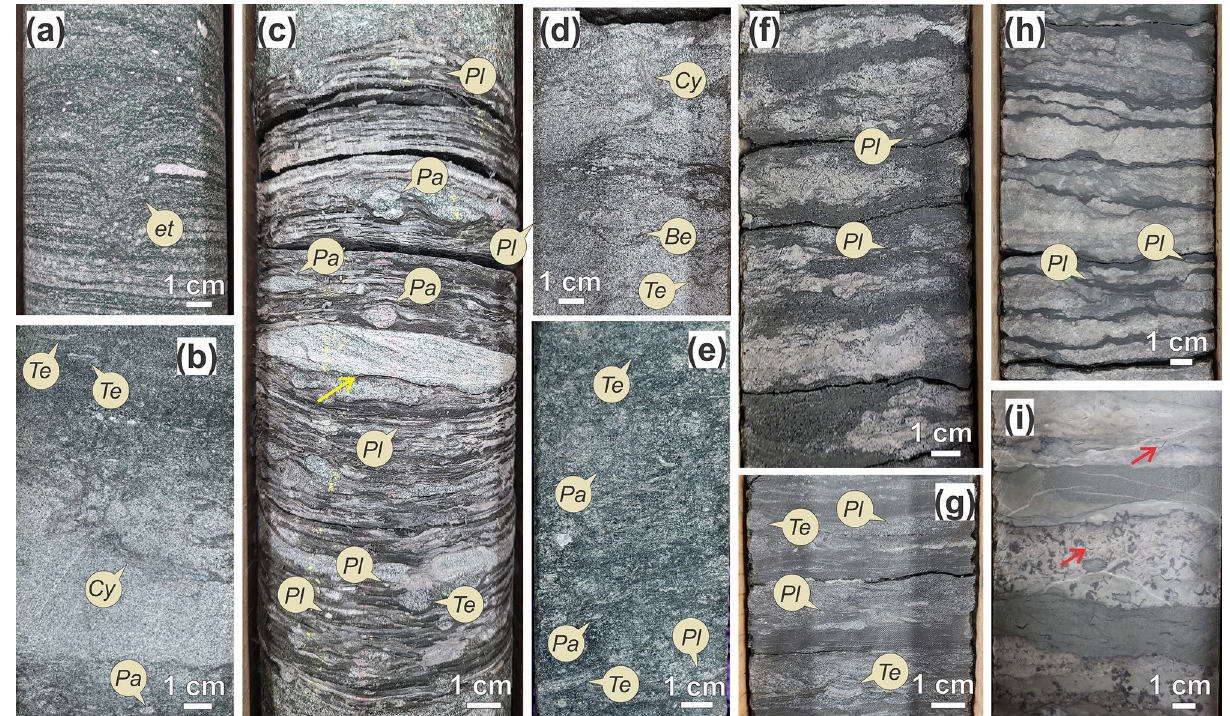
Figure 3. Trace fossils and sedimentary facies of Facies Association 2 (FA2). ( a ) Escape trace fossil (et) in cross-bedded glauconitic sandstone (Sxgl). ( b ) Teichichnus rectus and inclined Cylindrichnus concentricus in interbedded glauconitic sandstone and mudstone (Sgl-Mgl). ( c ) Parallel-laminated green mudstone (Mg) with very thin-bedded glauconitic sandstone layers and cross-laminated sand lenses (yellow arrow). Teichichnus rectus ( Te ), Palaeophycus isp. ( Pa ), and Planolites isp. ( Pl ). ( d ) Small Cylindrichnus concentricus and Bergaueria isp. ( Be ) in glauconitic sandstone (Sxgl). Scale bar is 1 cm. ( e ) Moderate to highly bioturbated glauconitic sandstone (Sgl-bio). Teichichnus rectus ( Te ) , Palaeophycus isp. ( Pa ), and Planolites isp. ( Pl ). ( f ) Interbedded glauconitic sandstone and limestone (Sgl-Lst) with Planolites isp. ( Pl ). ( g ) Teichichnus rectus ( Te ) and Planolites isp. ( Pl ) in interbedded glauconitic sandstone and mudstone (Sgl-Mgl). Note the presence of discrete thin intervals with undetermined bioturbation mottling. ( h ) Interbedded mudstone and limestone (M-Lst). ( i